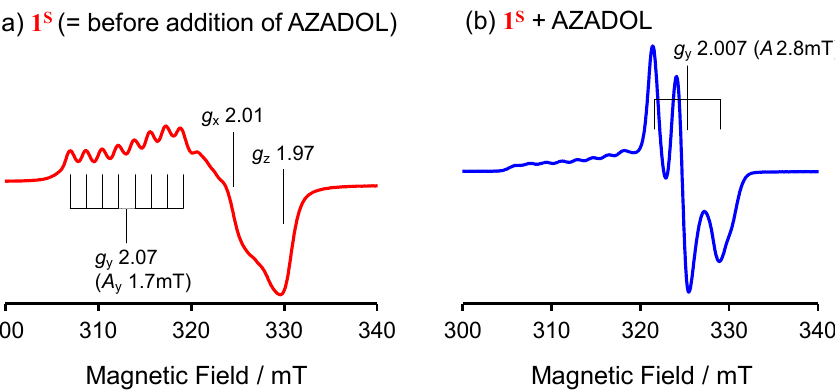
The EPR spectrum of the reaction mixture of 1 S and AZADOL exhibited signals at-